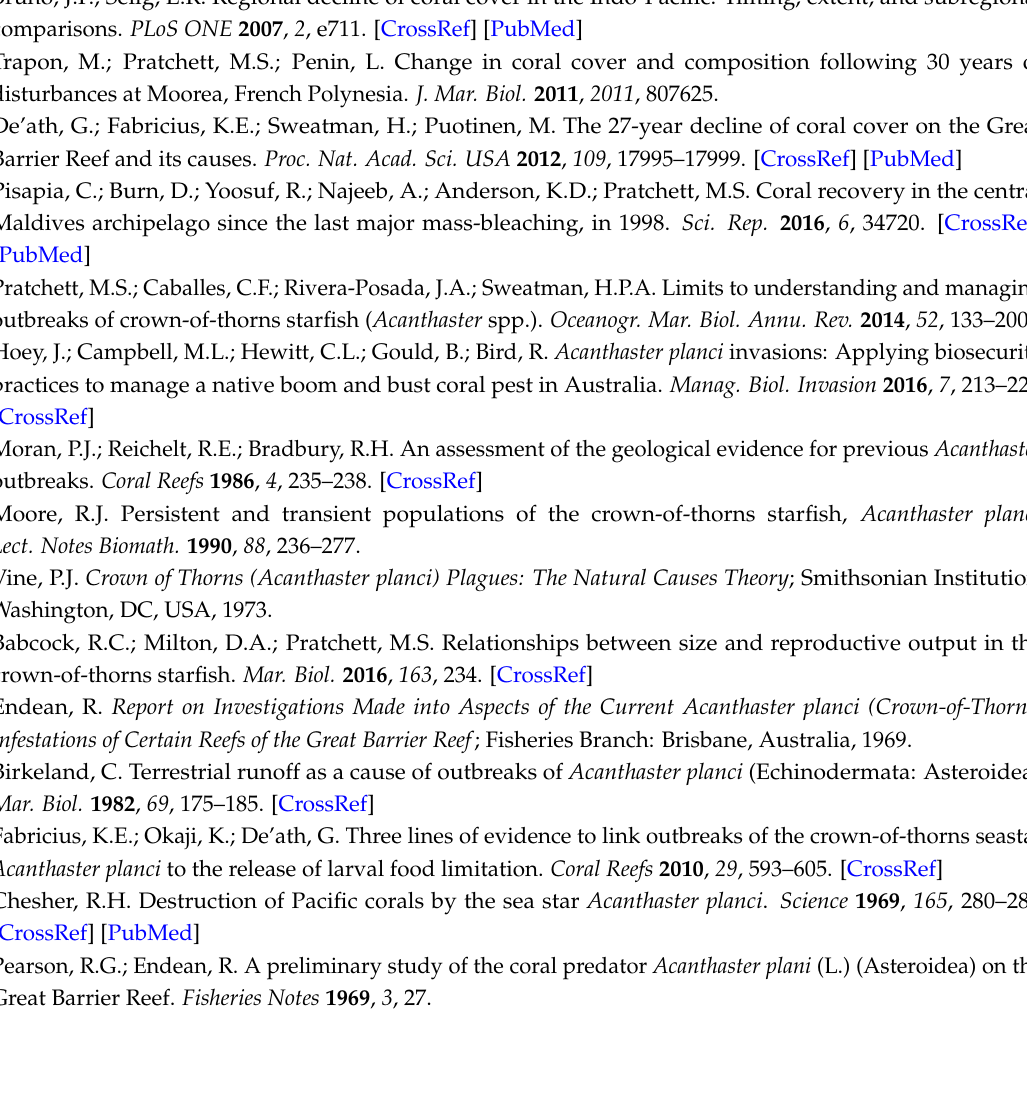
Figure S1: Inter-reader comparability for dry counts of crown-of-thorns starfish ( Acanthaster cf. solaris ) spines; Table S1: Posterior parameter estimates for a Bayesian von Bertalanffy three-parameter model; Table S2: Reef-specific posterior parameter estimates for a Bayesian von Bertalanffy three-parameter model; Data S1: cots_spines_wet_data.csv; Wet band count data from CoTS initiation box, 2013–2014. Acknowledgments: We are grateful for to those who assisted us in the collection of CoTS: Kristen Anderson, Zara-Louise Cowan, Jacob Johansen, Elmar Messmer, Kirsty Nash, Laura Richardson, Robert Streit, Stuart